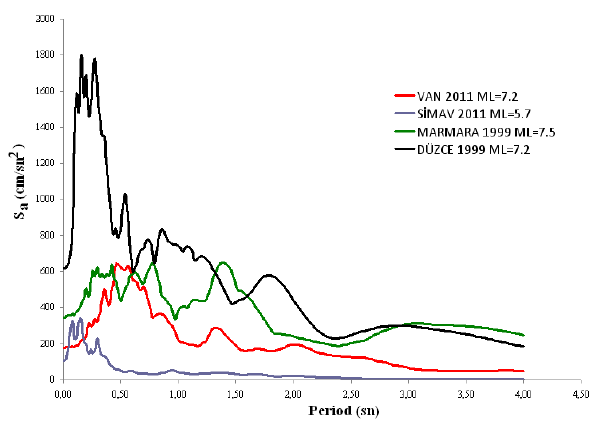
Fig. 4. Spectral acceleration values for four earthquakes in